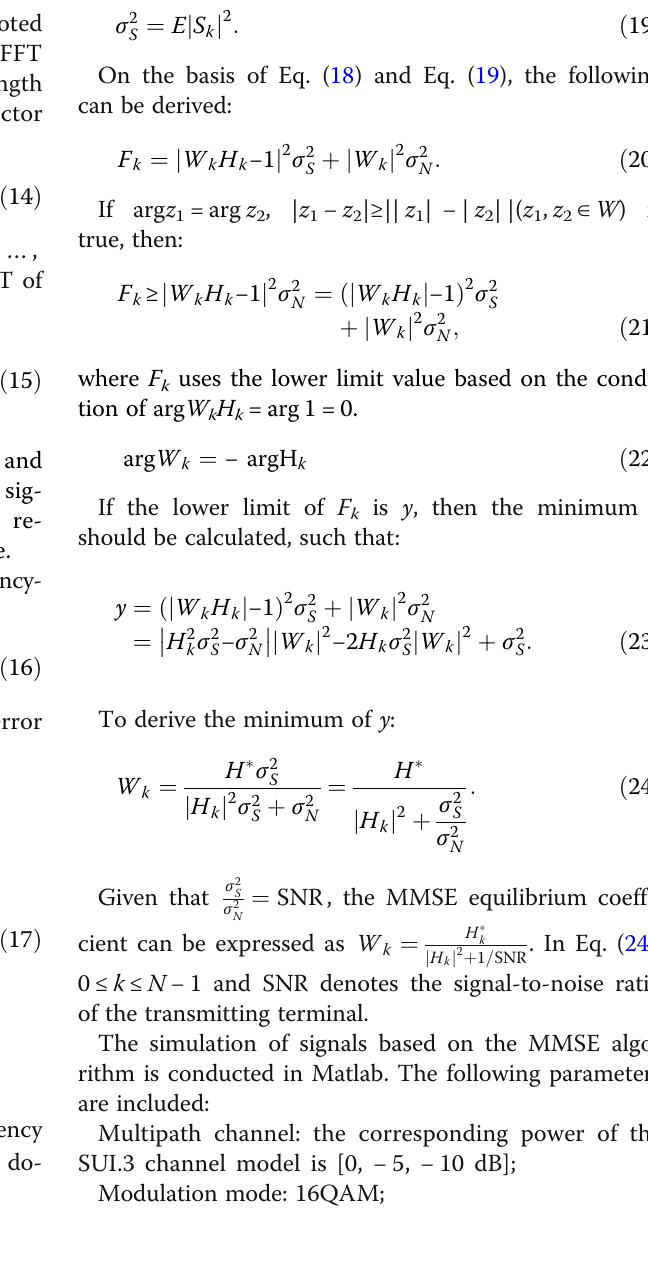
algorithm is applied as the frequency-domain equilib-